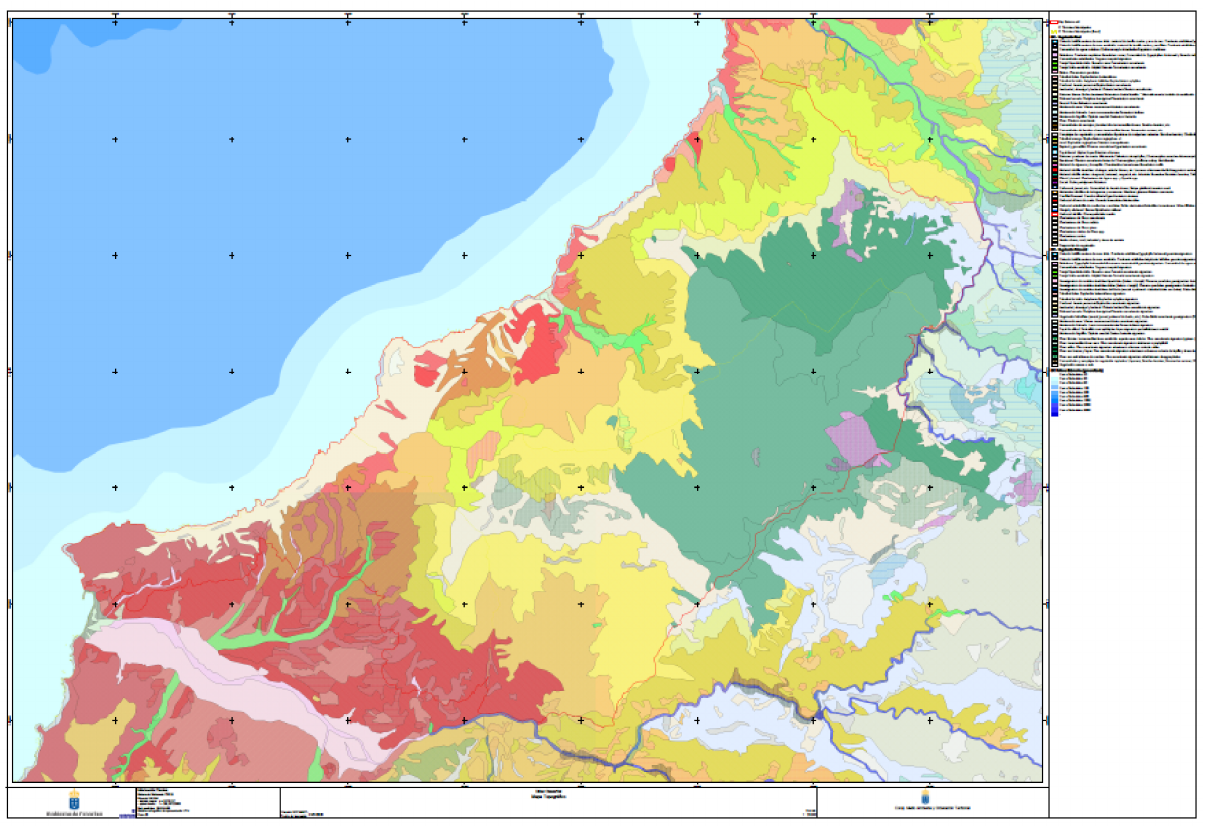
Figure A2. Topographic map of the area of Tamadaba, Gran Canaria. Source: Government of the island of Gran